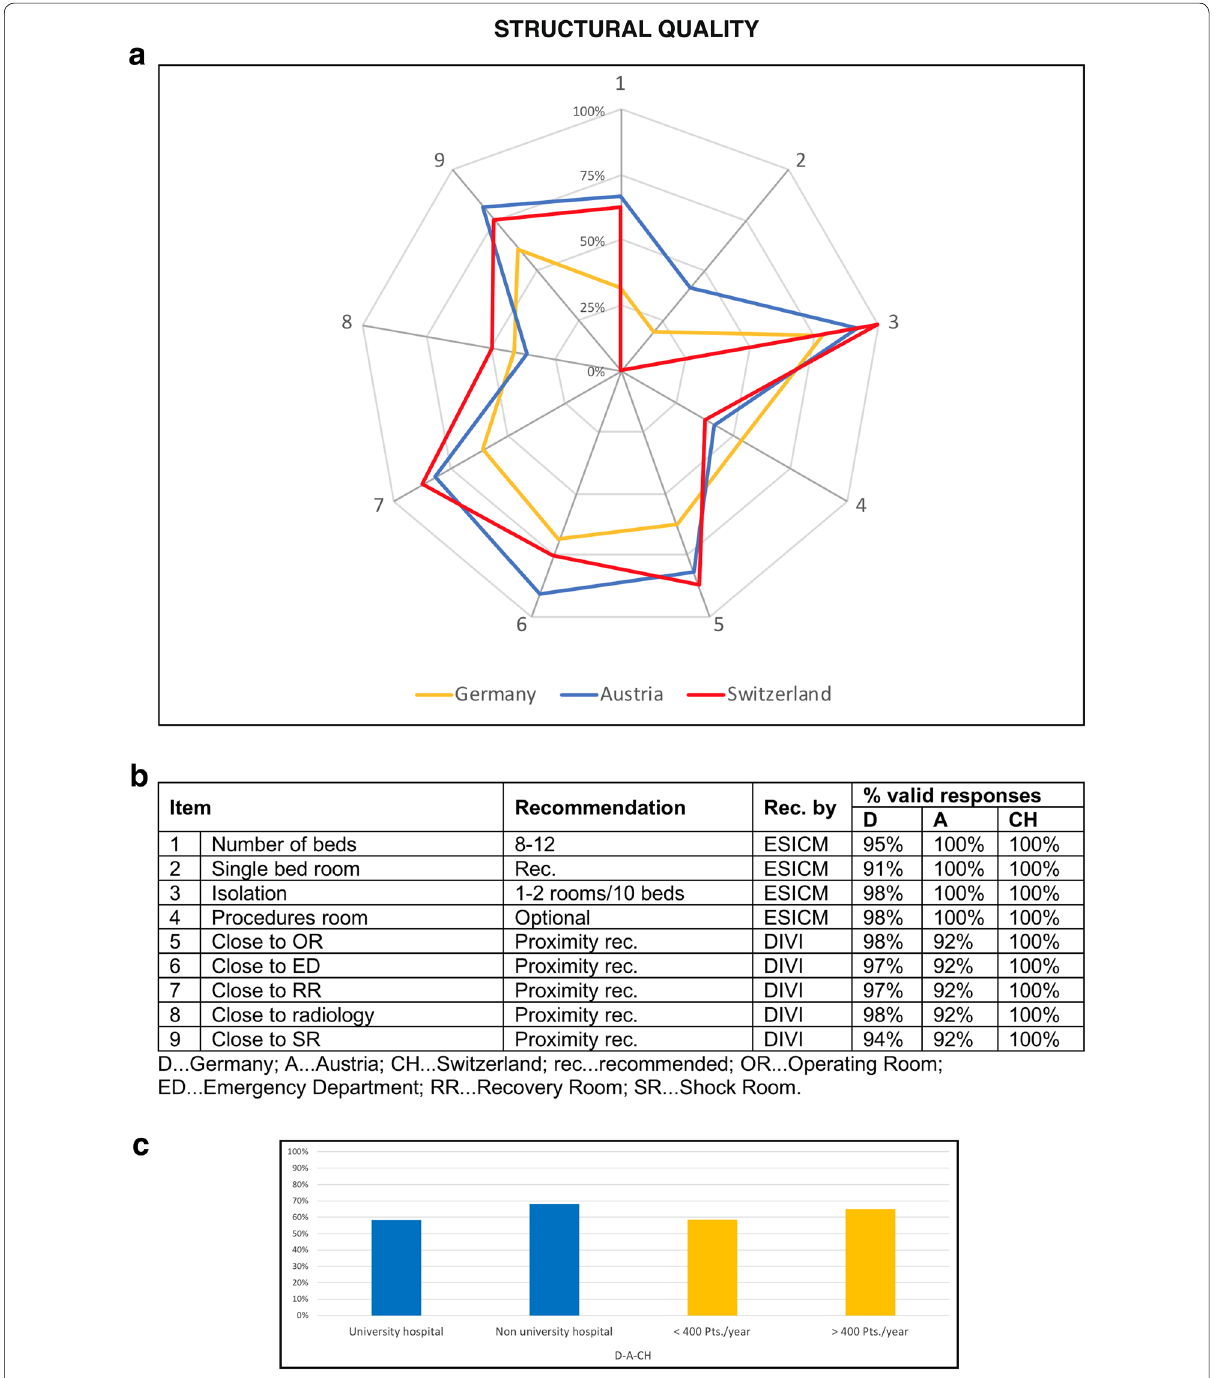
Fig. 1 Structural quality of PICUs in the “D–A–CH” region. The web diagram ( a ) displays the percentage (of valid responses) of PICUs meeting the recommendations for the different items surveyed. In the table ( b ), the valid response rates for the different items are listed. The bar charts ( c ) display the mean of all nine items concerning structural quality according to the sub-categories university/non-university hospital and patients treated